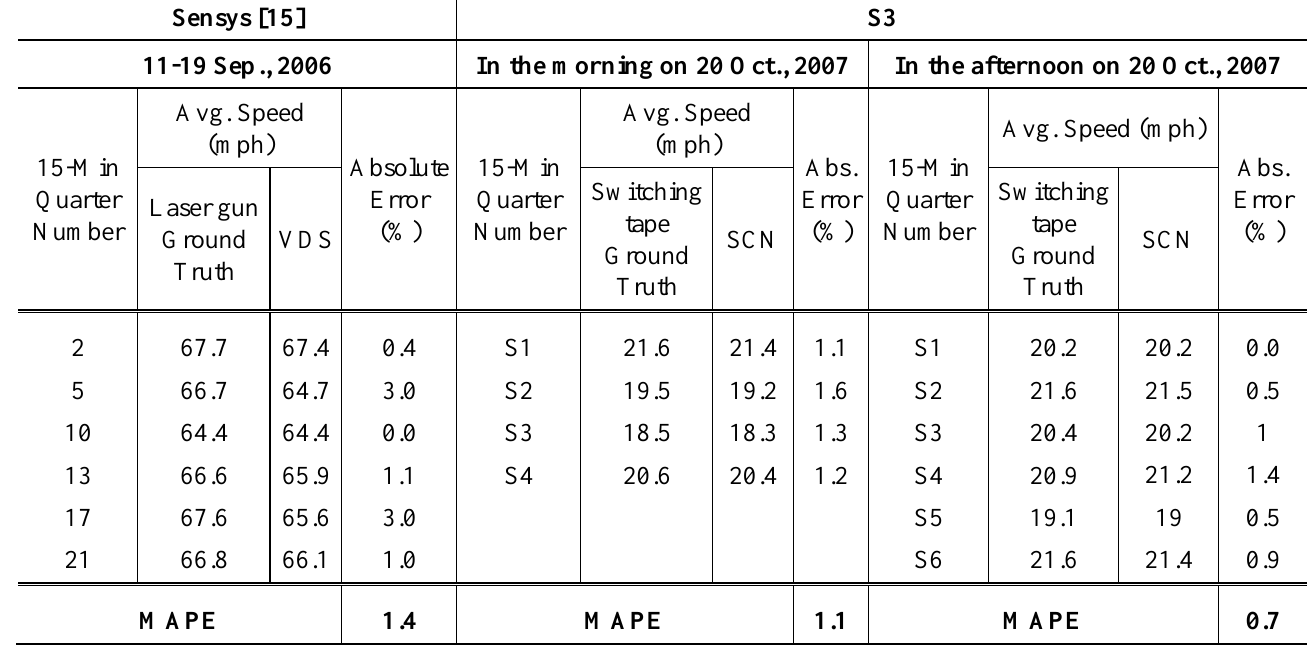
Table 5. Speed accuracy comparison between SCN and Sensys Wireless VDS